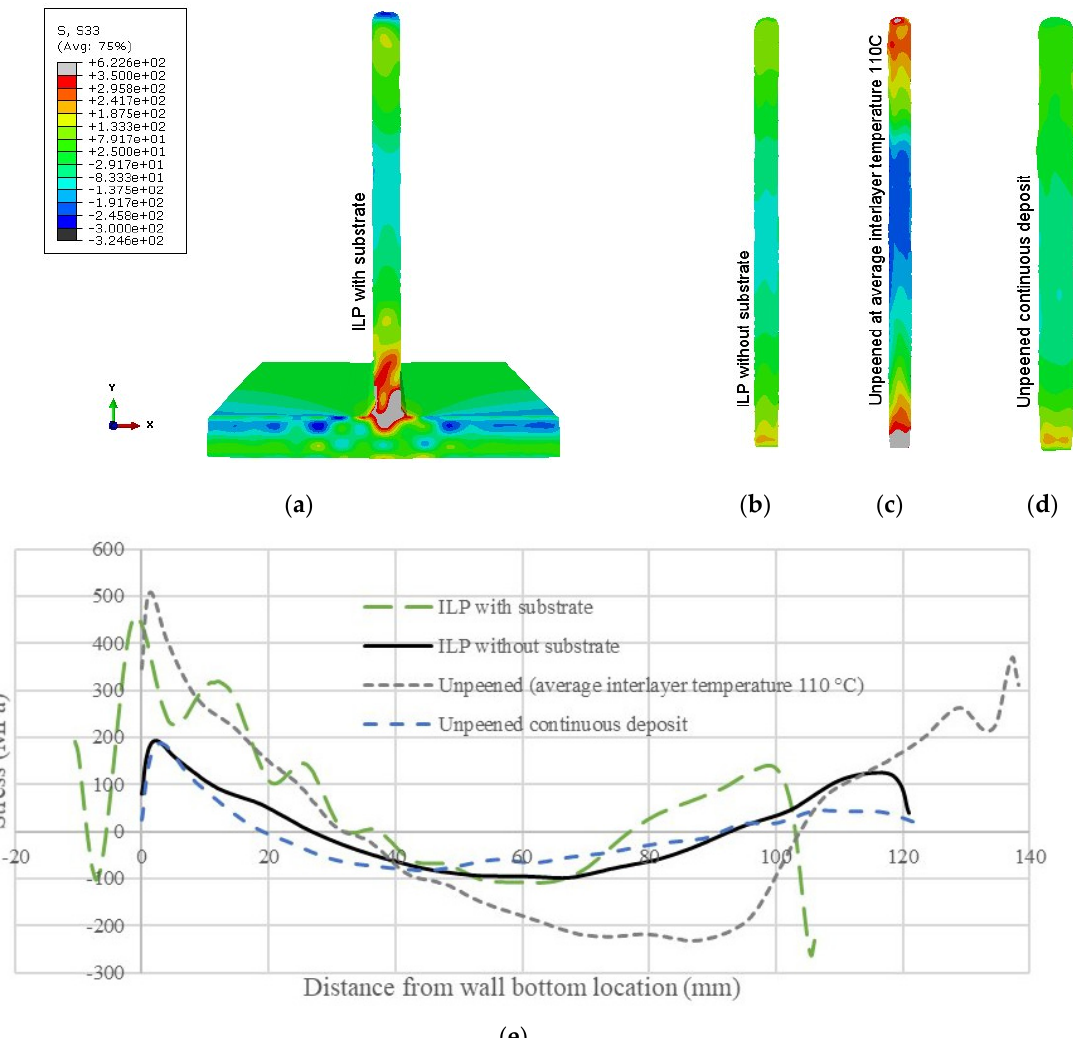
Figure 5. Residual stress results of single bead walls of different build conditions: ( a – d ) stress maps, ( e ) stress profiles at mid-thickness from the bottom to top of the walls.